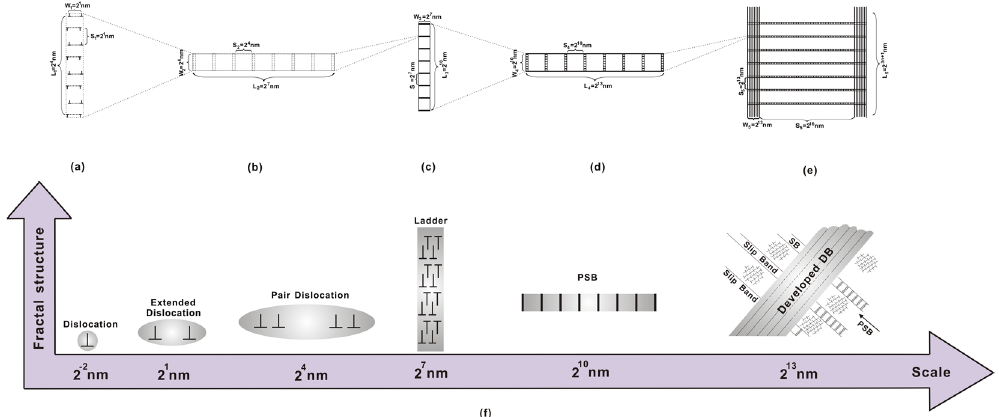
Figure 4. Dislocation Distribution based on the fractal principle. ( a – e ) Self-similarity of dislocation distribution; ( f ) Dislocation structural parameters at different